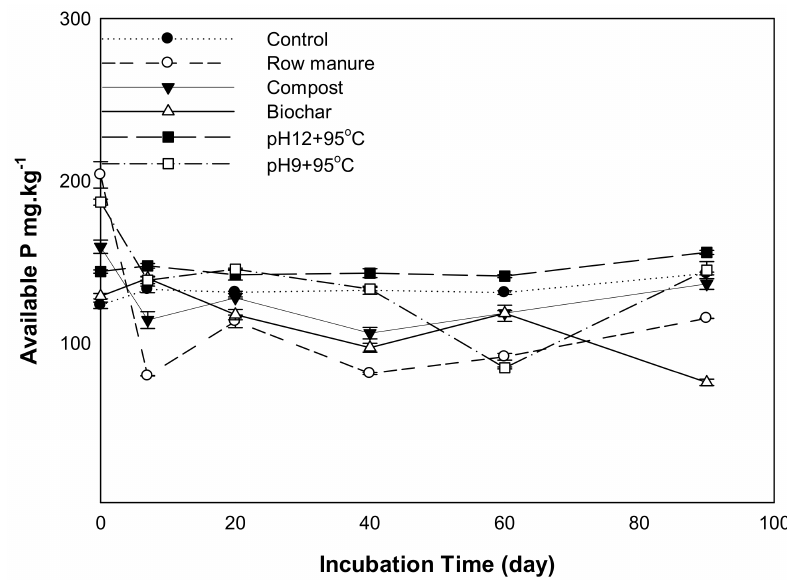
Figure 3. Available phosphorus affected by different organic amendments derived from cow manure at different incubation